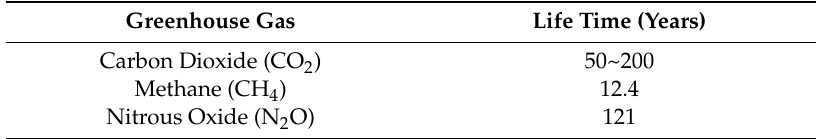
Table A1. Lifetime of greenhouse gases in the study [29].